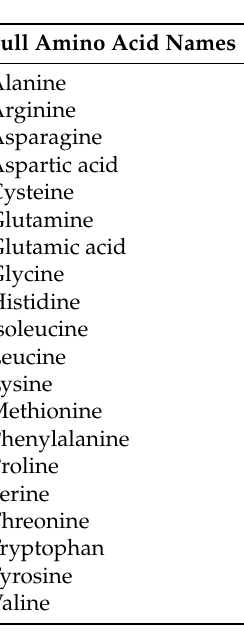
Table A1. Full names and corresponding one-letter codes of the amino